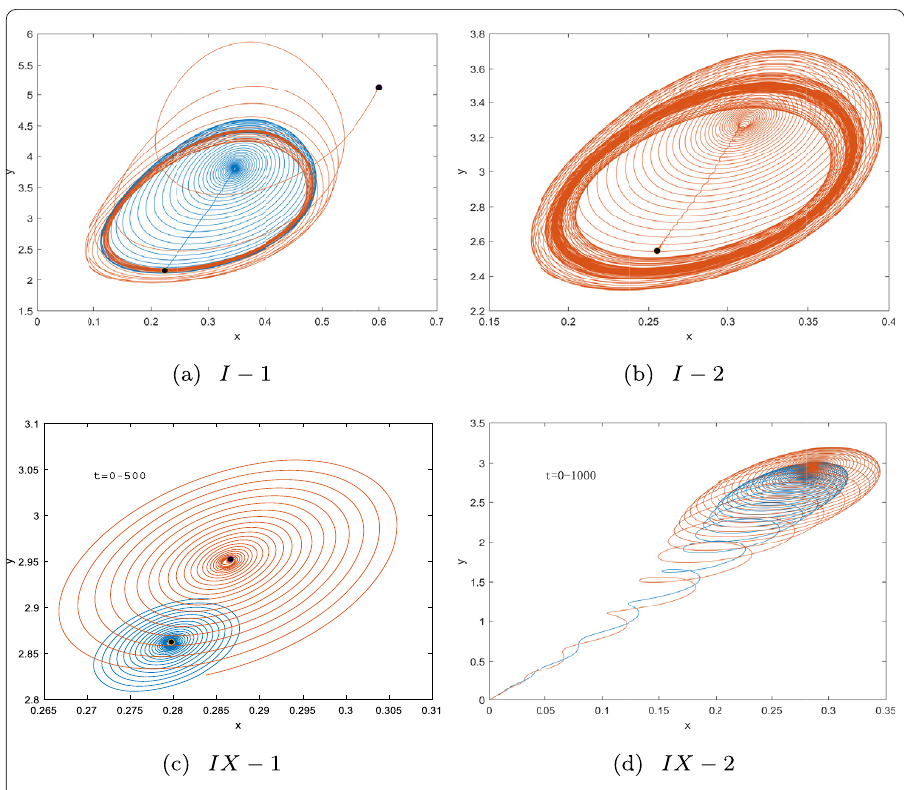
Figure 2 Trajectories of system (1) with different parameters and initializations in regions ( I and IX ) of Fig. 1, where the ( τ , r ) of I , IX are (5,0.1) and (5.15,0.0975), respectively. (a)The initial values of the variable are (0.6001,5.1389) and (0.2333,2.159), and they finally stabilize to periodic solutions with large amplitude and small amplitude respectively. (b)The initial value of the variable is (0.25526,2.5469). In fact, it is similar to